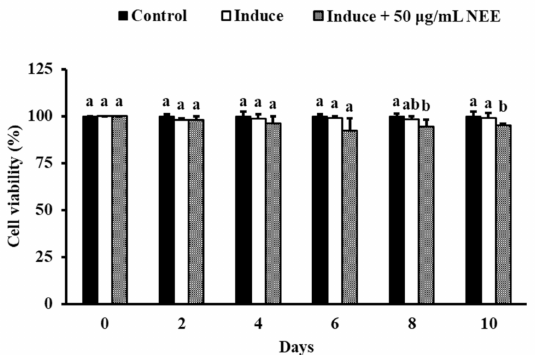
Figure 2. Effects of NEE on cell viability in 3T3-L1 preadipocytes. For 10 days, 3T3-L1 adipocytes were treated or not treated with 50 µ g/mL NEE. Cells were harvested every two days, and non-differentiation preadipocytes were the control. Duncan’s test was used to determine the significance of the variation in cell proliferation. The data are the means and standard deviations ( n = 3). Significant differences ( p < 0.05) between the different concentrations of the NEE group are indicated by different letters (a,b)